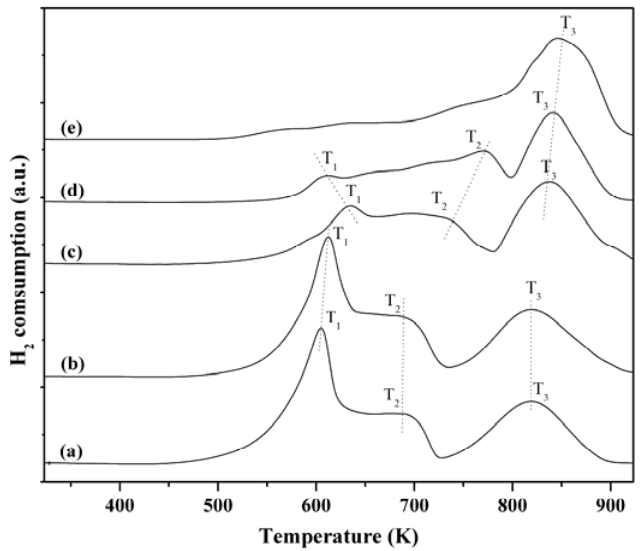
Figure 8. H 2 ‐ TPR profiles of 10Mn ‐ 5Co/TiO 2 catalysts calcined at various temperatures: ( a ) 573 K; Figure 8. H 2 -TPR profiles of 10Mn-5Co/TiO 2 catalysts calcined at various temperatures: ( a ) 573 K; ( b ) 673 K; ( c ) 773 K; ( d ) 873 K; and ( e ) 973 K. ( b ) 673 K; ( c ) 773 K; ( d ) 873 K; and ( e ) 973